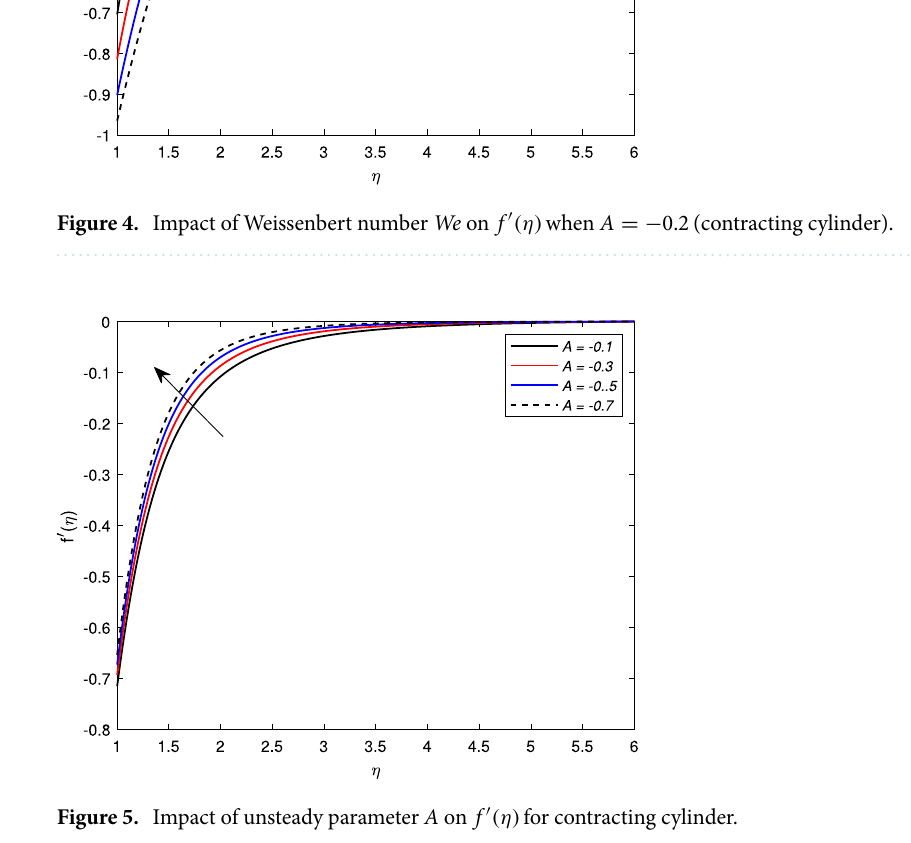
Figure 5. Impact of unsteady parameter A on f ′ (η) for contracting